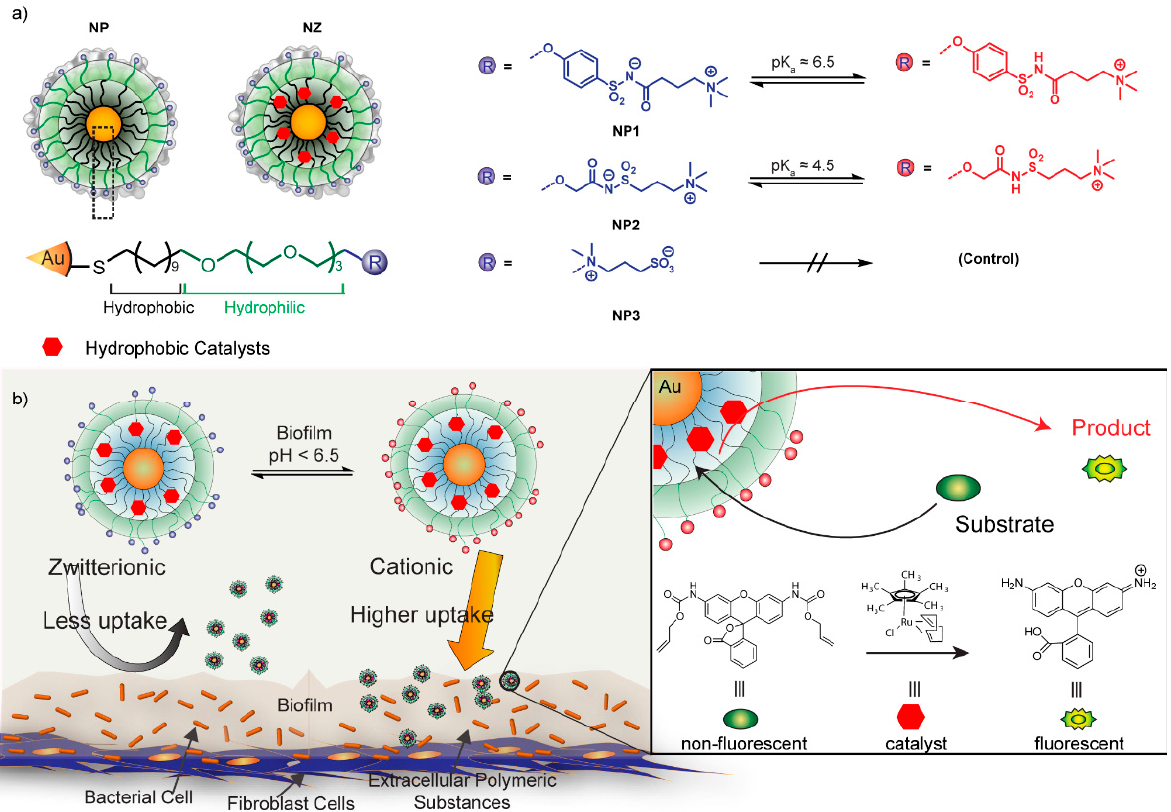
Figure 9. ( a ) Schematic representation of nanoparticles, nanozymes and molecular structures of pH-switchable and control ligands on AuNPs. ( b ) Schematic representation showing selective targeting of biofilm infections using pH-responsive nanoparticles and NZ-mediated fluorogenesis of prodye inside of biofilms. (Adapted with permission from Reference [138]; Published by American Chemical Society, 2018).